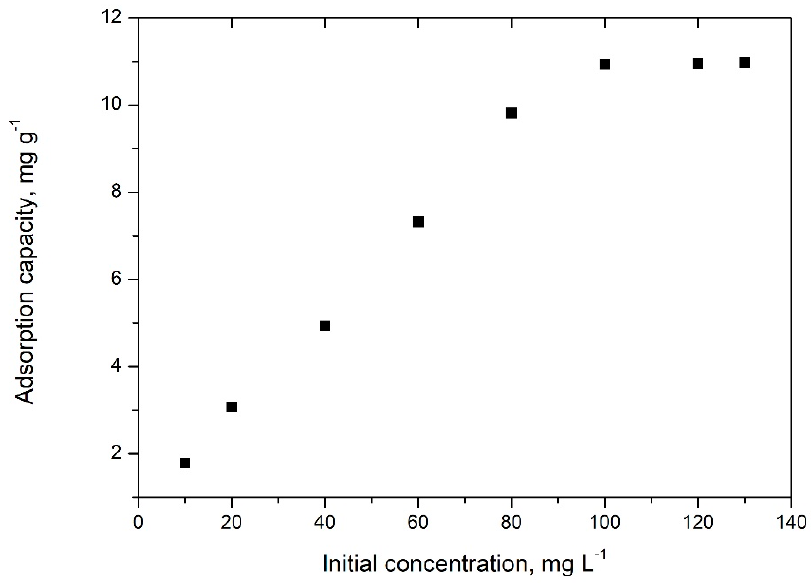
Figure 15. Initial concentration effect on adsorption capacity.